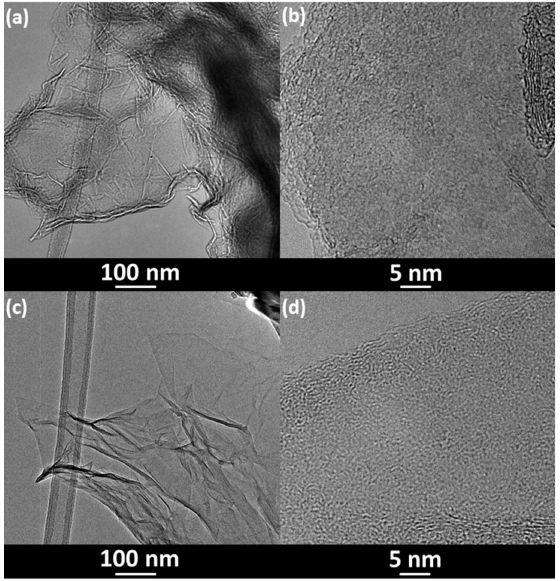
Figure 1. TEM images of ( a , b ) RGO-CH 2 O [23] and ( c , d ) RGO-CH 2 O-MWT. The PEELS spectra confirm structural differences due to MWT conditions in intensity and shape of elastic and inelastic electron spectra (Figure S1—Supplementary Materials). Differences were observed in the carbon K line (C_K-edge), where for the sample rGO- CH 2 O there is a double band at 289 and 318 eV, while for the rGO-CH 2 O-MWT sample a single band at 289 eV confirming its higher structural